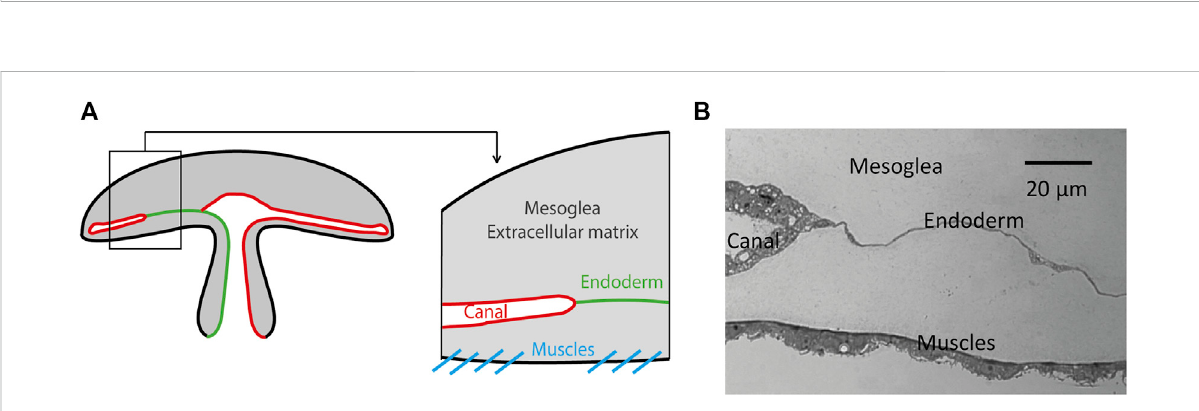
FIGURE 2 Anatomical position of the canals in the jelly fi sh Aurelia. The canals are surrounded by an endodermal layer positioned just above the lower epidermis with muscles. (A) Schematic representation. (B) Optical view of a histological 4 μ m thick microtome slice of a fi xed jelly fi